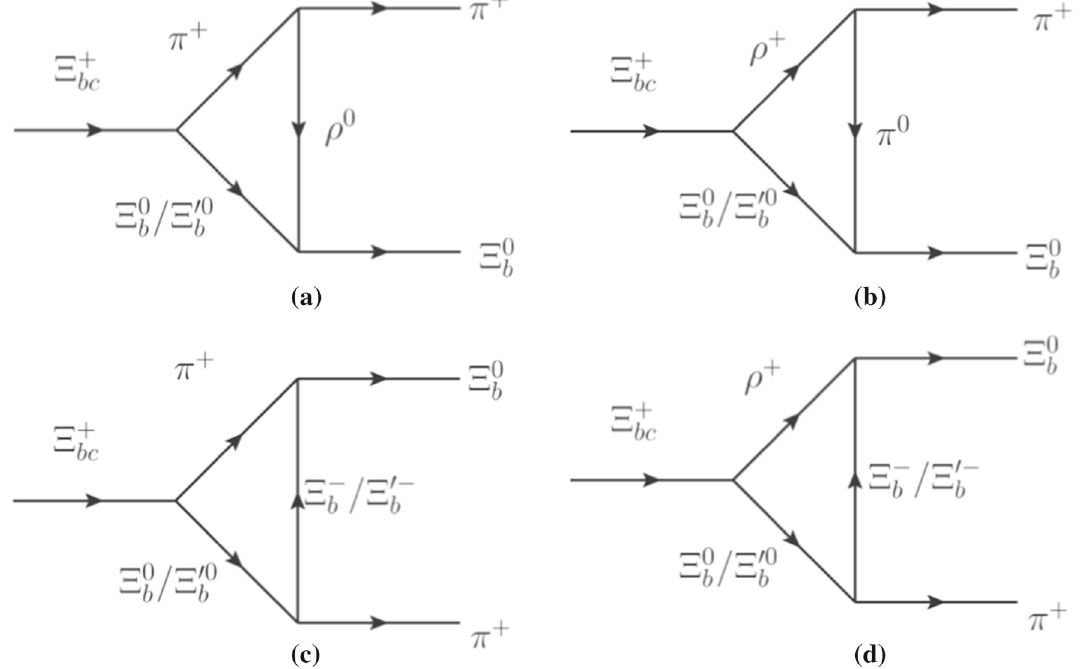
Fig. 2 The long-distance rescattering contributions to (cid:2) + with q = p − p (cid:6) and M B factors f i and g i can be evaluated under different theoretical